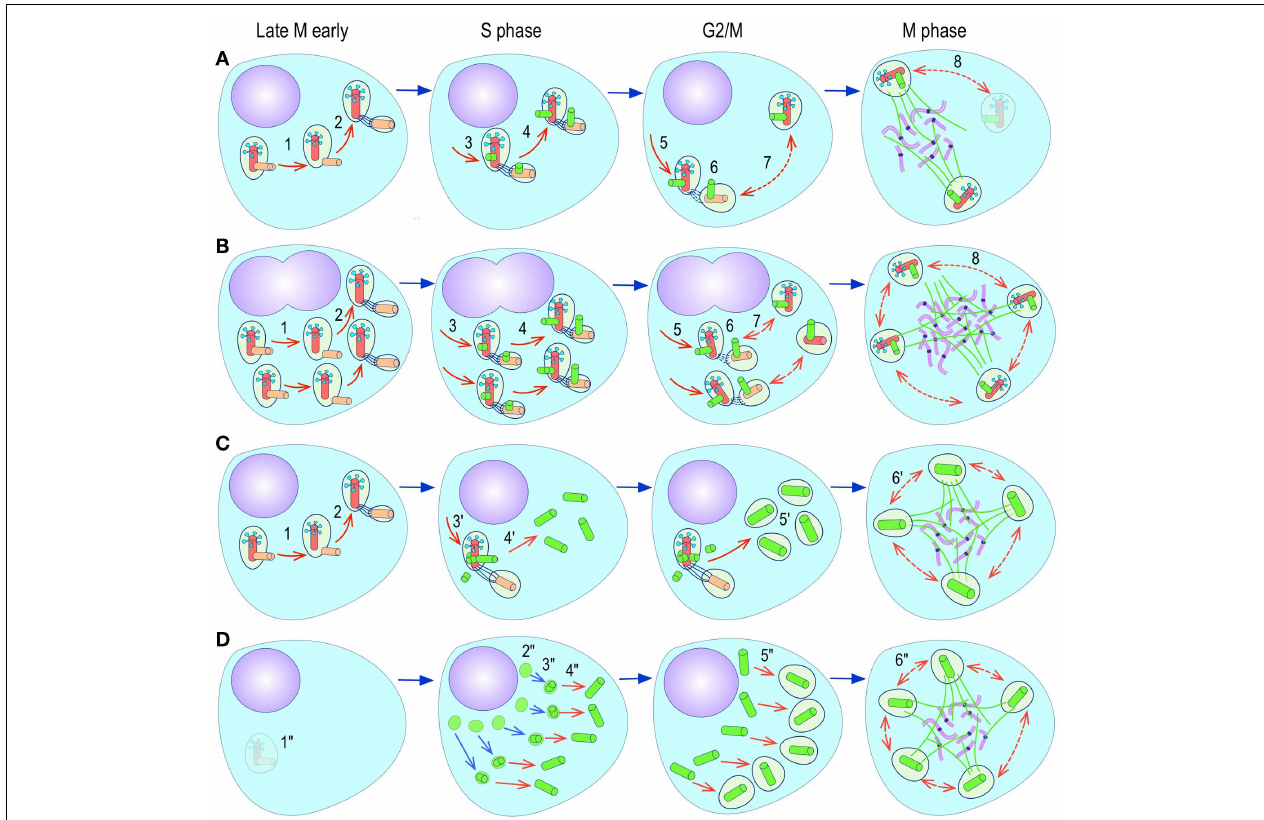
FIGURE 4 | Pathways to supernumerary centrosomes in cancer . Canonical template-dependent centrosome replication pathway (A) . Normal centrosome duplication proceeds sequentially in the following steps: centriole disengagement (1), linker fiber development (2), procentriole nucleation (3), centriole elongation (4), linker dissolution (5), centrosome maturation (6) and separation, before (7) and after (8) NEB.There are at least three pathways to supernumerary centrosomes in cancer (B–D) . Centrosome accumulation pathway due to polyploidization events (B) . Events such as cytokinesis failure, mitotic slippage (mitotic failure before cytokinesis), etc., with or without normal DNA replication, result in accumulation of normally replicated centrosomes, which execute all stages of replication as in the canonical template-dependent pathway A. Centrosome over-replication pathway (C)